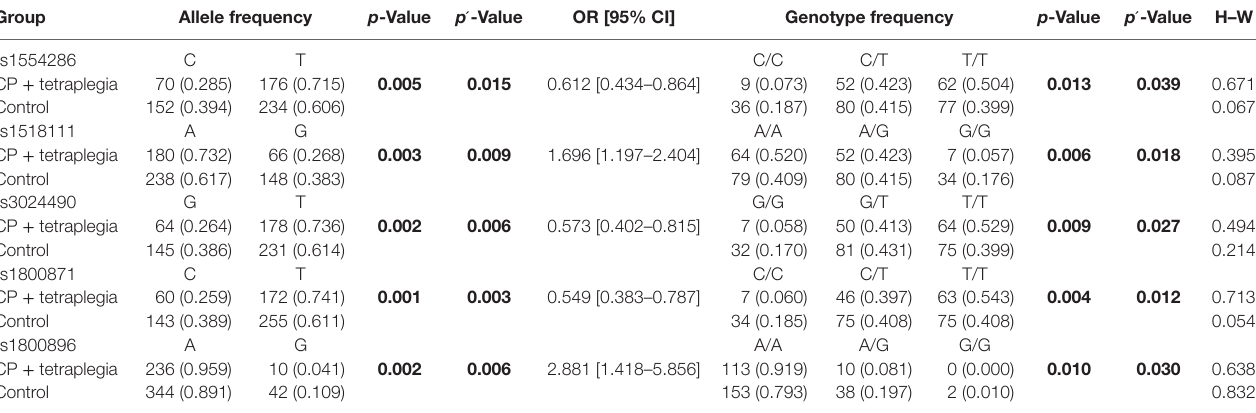
TaBle 5 | Allele and genotype frequencies of IL-10 in cerebral palsy (CP) patient subgroups and controls.